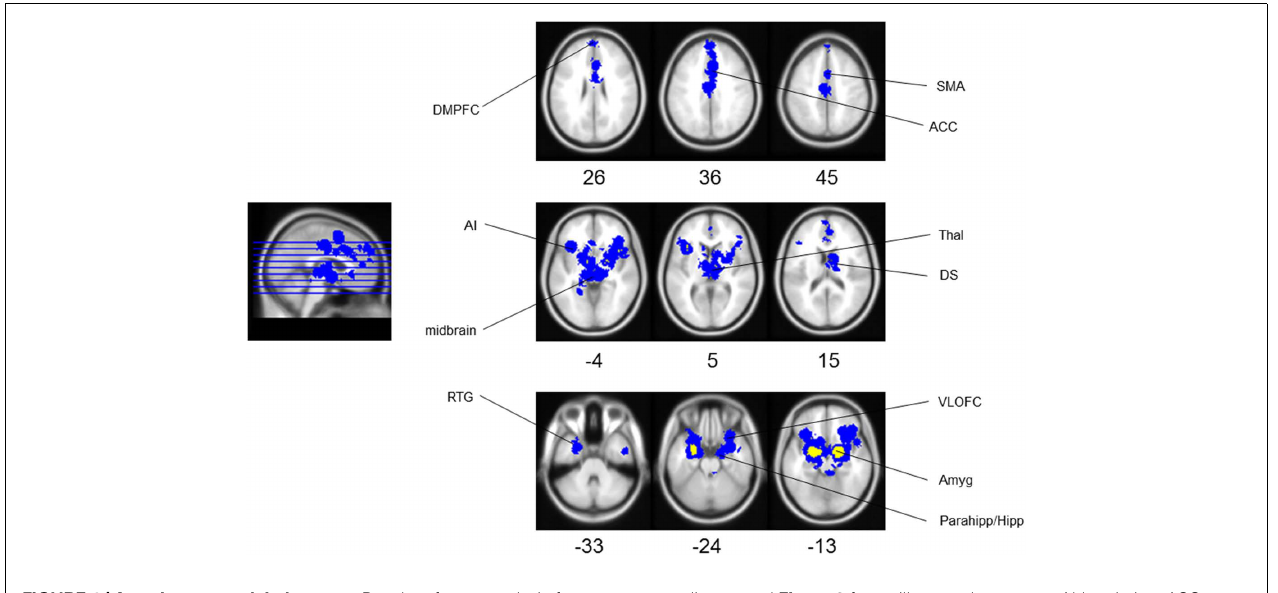
coordinates and Figure 2 for an illustrated summary. Abbreviation: ACC, anterior cingulate cortex; AI, anterior insula; Amyg, amygdala; DMPFC, dorsomedial prefrontal cortex; DS, dorsal striatum; Parahipp/Hipp, parahippocampus/hippocampus; RTG, rostral temporal gyri; SMA,